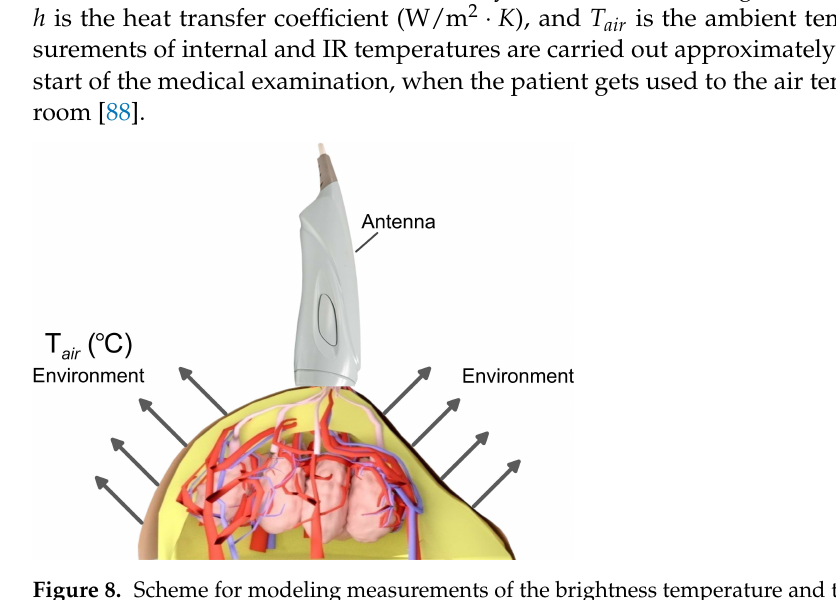
Figure 8. Scheme for modeling measurements of the brightness temperature and the IR temperature of the